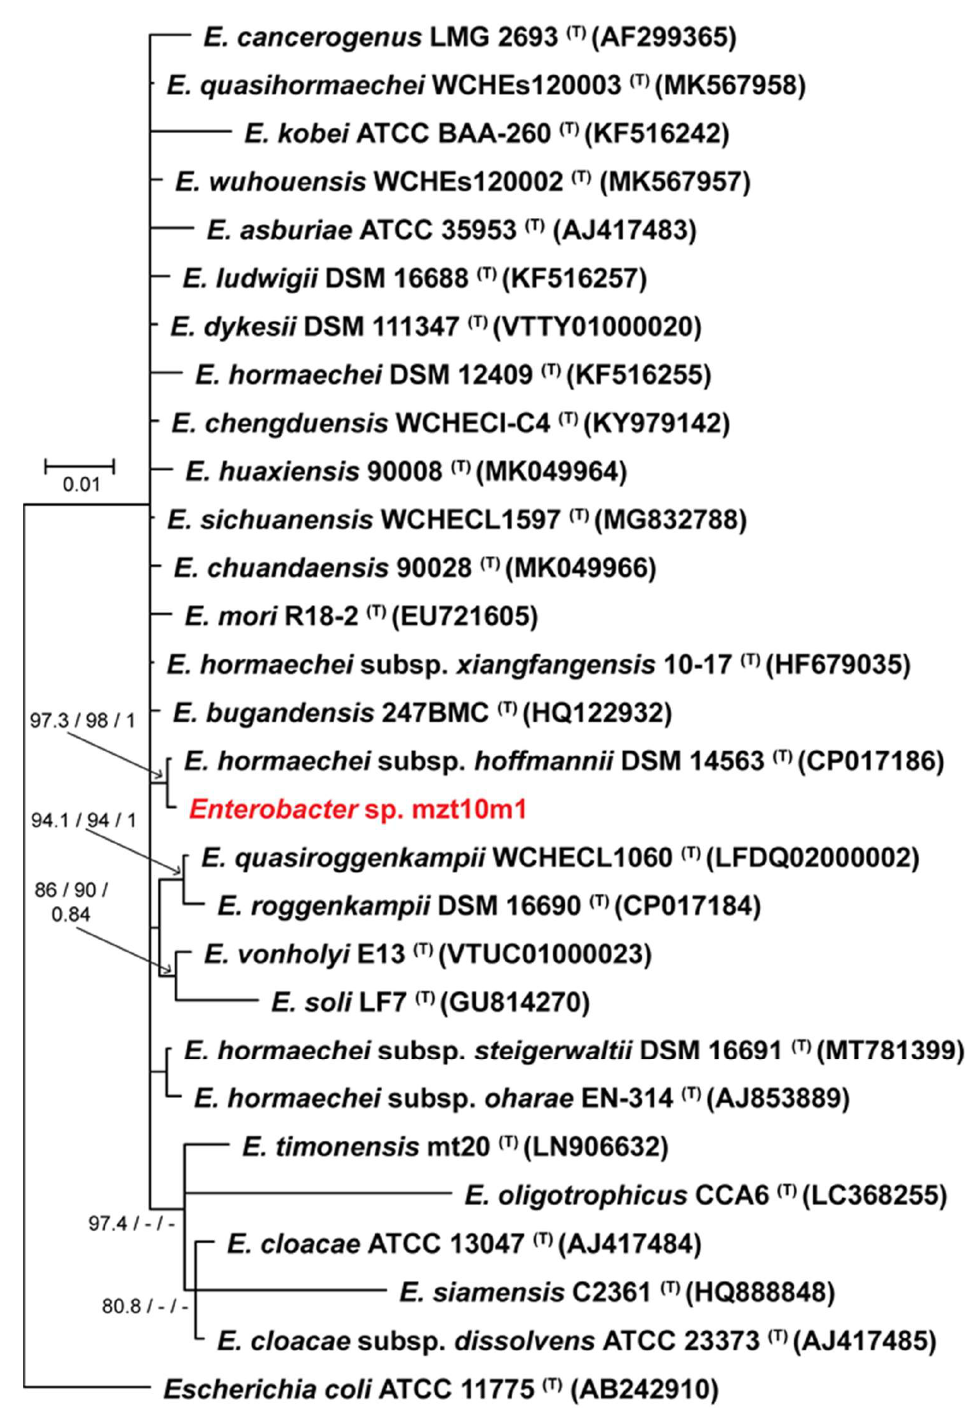
Figure 5. Bayesian inference phylogenetic tree of MZT10M1 isolate and all accepted species of Enterobacter based on the 16S rDNA sequences. The species Escherichia coli (ATCC11775) was used as outgroup. Strains marked with a “T” and emphasized in bold correspond to sequences from type-strains. The scale bar of 0.01 represents the number of changes per site. MLsh-ALRT, ultrafast bootstrap values, and posterior probability support values are presented on the left side of nodes.